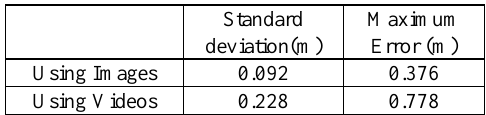
Table 5. Mapping accuracies using images and